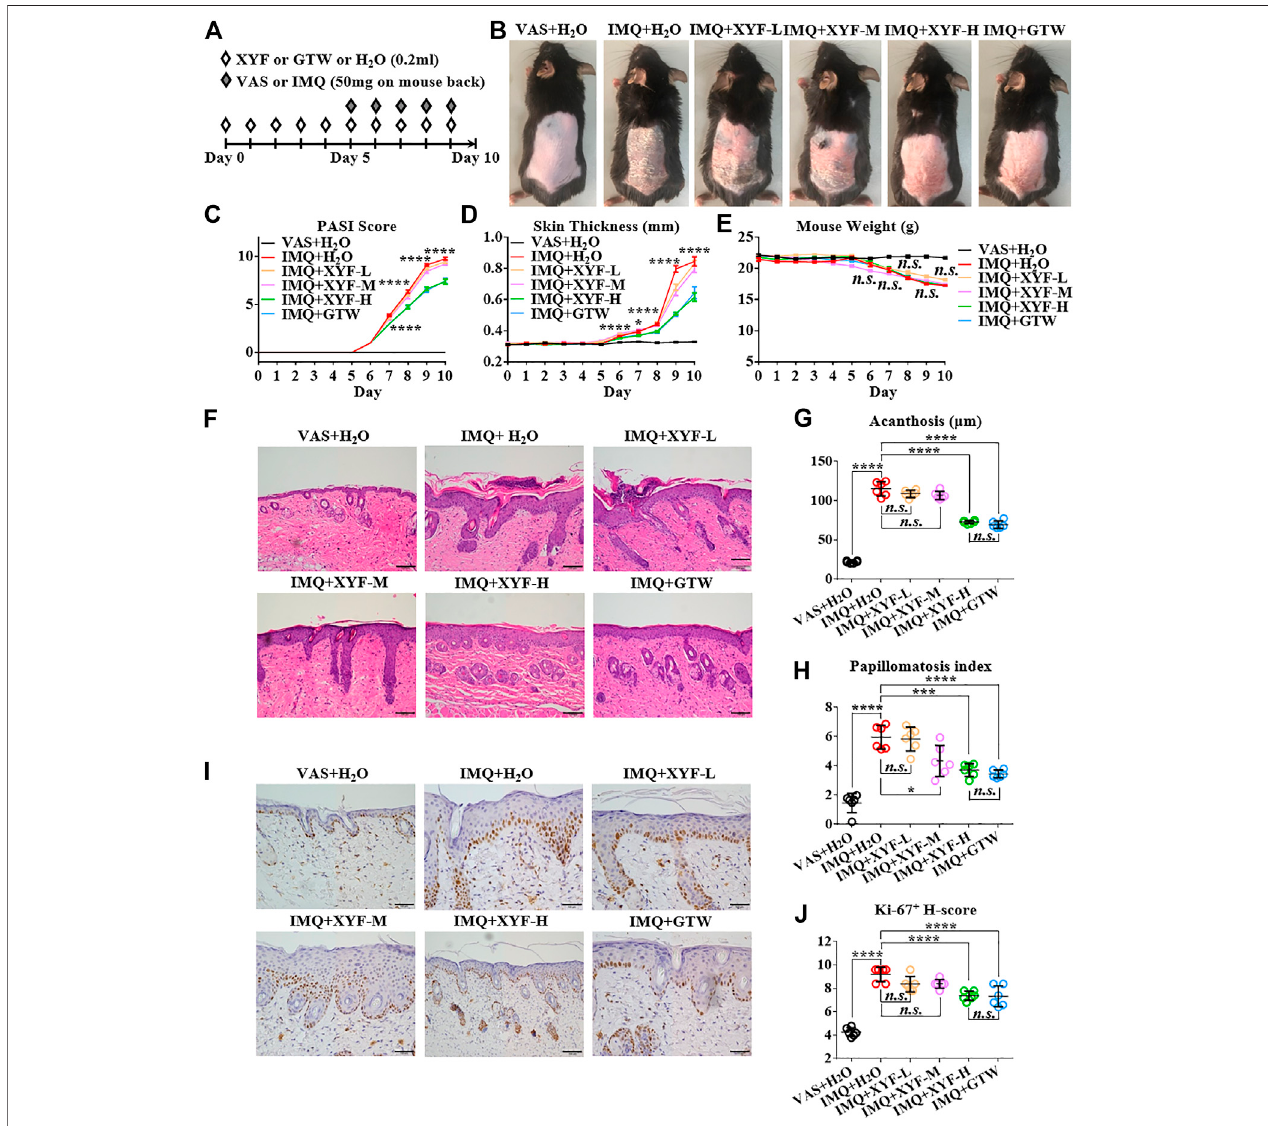
FIGURE 2 | High-dose Xiao-Yin-Fang alleviated imiquimod-induced psoriasis-like skin in fl ammation on mouse back. (A) Schematic of the experimental procedures.Miceweregivendifferent-doseXiao-Yin-Fang(XYF),multi-glycosideof TripterygiumwilfordiiHook.f. (GTW)solutionordistilledwater(H 2 O)bygavagetwice dailyfromday0today9,andreceivedimiquimod (IMQ)orVaseline(VAS)applicationonshavedbackskinonceadayfromday5today9. (B) Representativepicturesof mouse skin lesions (XYF-L, low-dose XYL; XYF-M, medium-dose XYF; XYF-H, high-dose XYF). (C – E) Evaluation of PASI score (C) , skin thickness (D) and body weight (E) of mice. The statistic differences between IMQ + XYF-H group and IMQ + H 2 O group were annotated ( n (cid:2) 54, three independent experiments). (F) H&E staining and calculated epidermal acanthosis (G) and papillomatosis index (H) (x200; bar (cid:2) 100 μ m; n (cid:2) 36, three independent experiments). (I) Ki-67 staining and assessment of its H-score of epidermal fi elds (J) (x200; bar (cid:2) 100 μ m; n (cid:2) 36, three independent experiments). The data were presented as mean ± s.e.m.